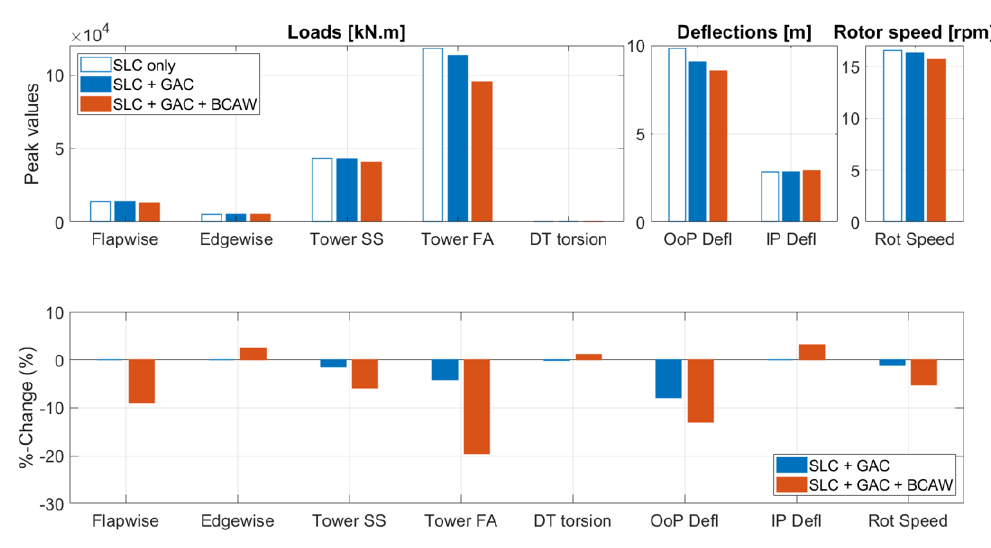
Figure A8. Variation of the maximum absolute transient (peak) values of the primary and secondary metrics under DLC 1.3 with different control architectures. Top—Peak dimensional values; Bottom— Percentage changes with respect to ‘SLC Only’ case.